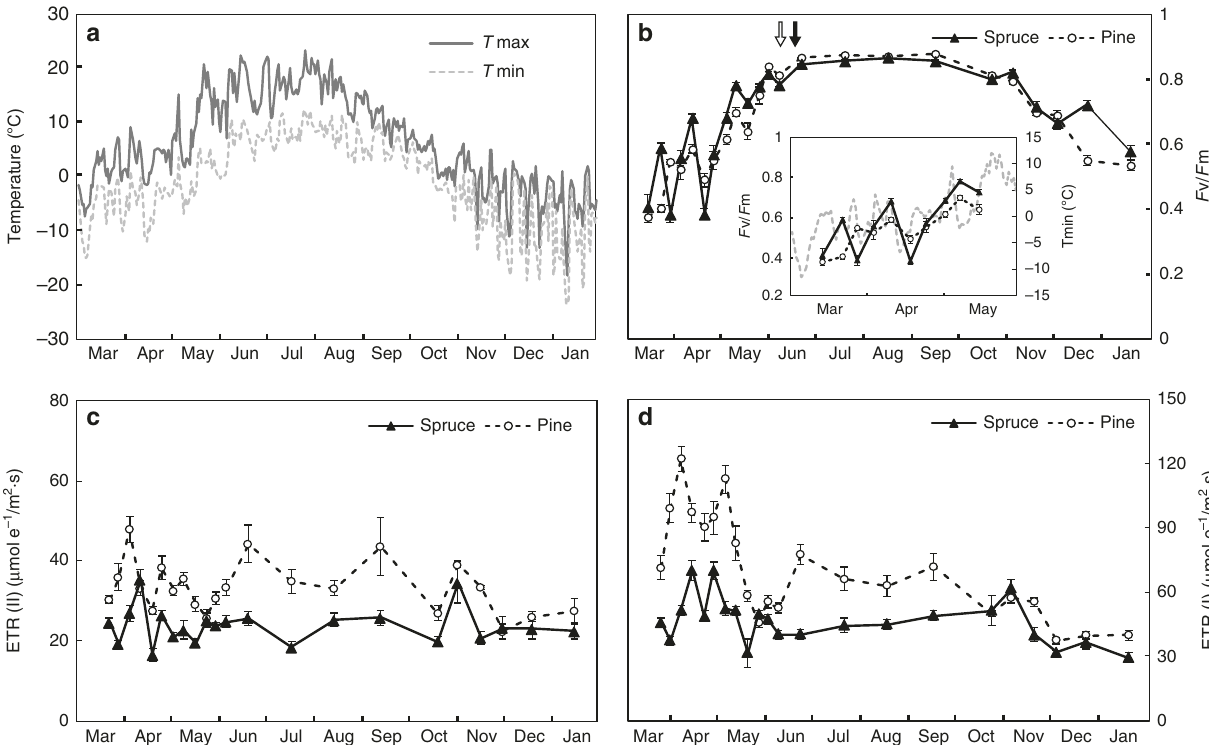
Fig. 1 Scots pine and Norway spruce demonstrate clear differences in the capacity for photosynthetic performance during the transition period from winter to summer. Two mature conifer trees, Pinus sylvestris (Scots pine) and Picea abies (Norway spruce), located near Vännäs, Sweden, were selected for analysis. Needles on south-facing branches that were developed in 2016 were used for the analysis. Needles of Scots pine (open circle) and Norway spruce (closed triangle) were collected during March 2017 through January 2018. a Air temperature of daily maximal (solid line) and minimal (dash line) temperature for the period February 2017 to January 2018. b F v / F m , maximum quantum ef fi ciency of photosystem II (PSII) photochemistry. Data collected from March to May are shown in a close-up view. The dates of budburst in Scots Pine and Norway spruce are indicated with open and closed arrows, respectively. c , d ETR(II) and ETR(I), electron transport rate through PSII and through PSI, respectively. Data were collected under actinic light intensity of 1292 µ mol photons m − 2 s − 1 . Each data point represents mean of six biological replicates (mean ± SE, n =